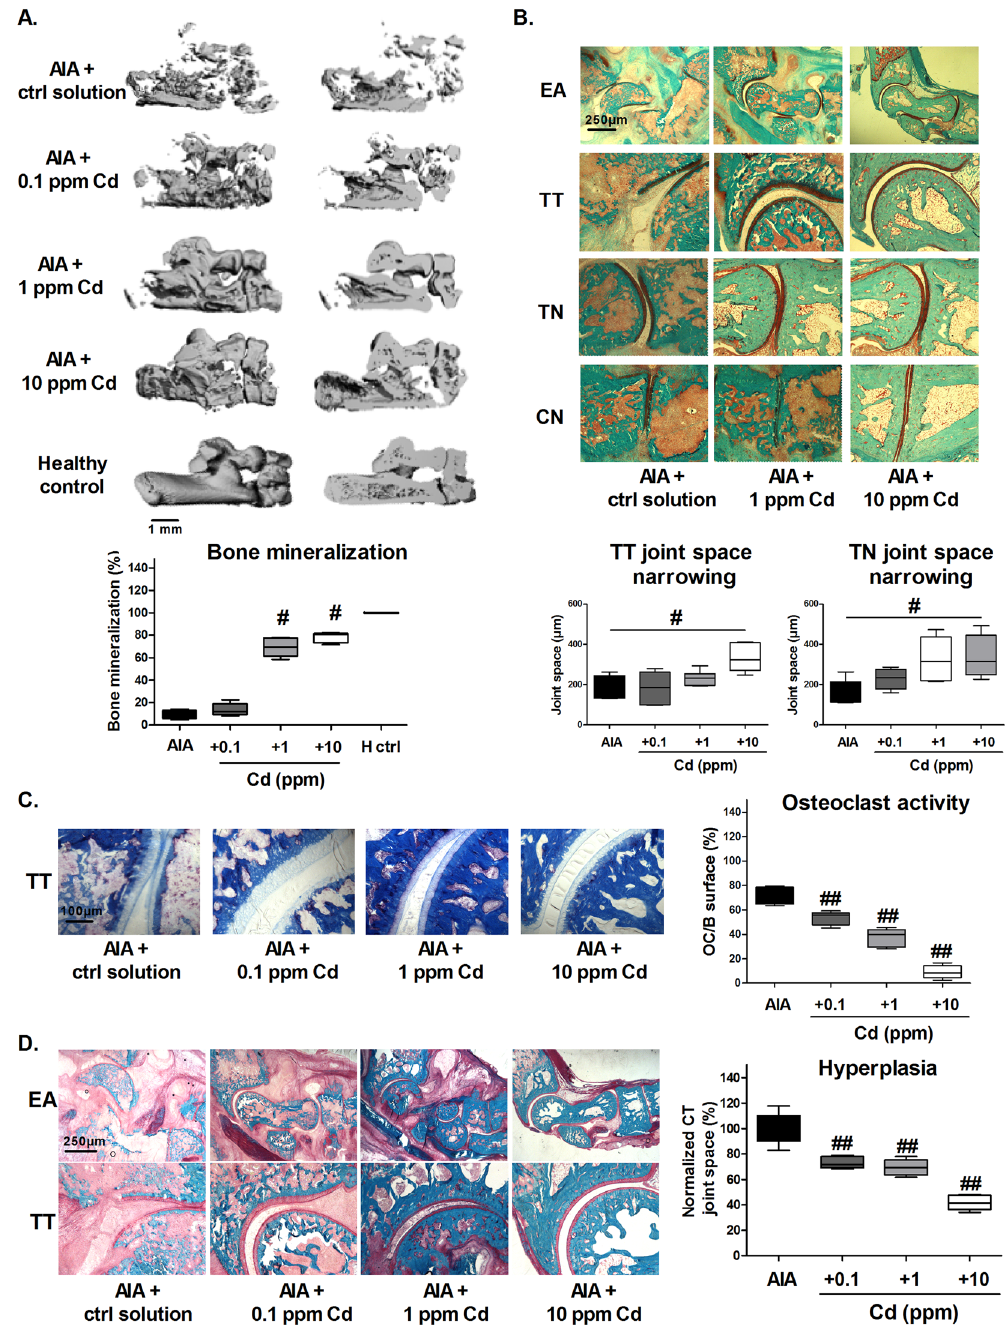
Figure 4. Cd intra-articular injection reduces inflammation-induced bone loss and cartilage destruction in AIA rats. ( A ) 3D-images reconstructed after micro-computed tomography analysis of hind ankle bones and quantification of bone mineralization of navicular bone ( B ). Safarin-O Cartilage staining and joint space narrowing quantification between talus and tibial or talus and navicular bones. Mineralized tissue in green, cartilage in red-orange. ( C ) TRAP staining in the TT space and quantification of osteoclast activity ( D ). Representative modified trichromatic Goldner staining on ankle sections: blue/green/turquoise: mineralized tissue; red periosteal layer and non-mineralized bone matrix; yellow/orange: bone marrow and other soft tissues; quantification of hyperplasia as calcaneo tibial joint space. EA: entire ankle; TT: talo-tibial; TN: talo- navicular; CN: cuneo-navicular. Data are the mean of two independent measures on 6 animals per group, excepting the AIA plus Cd-1 ppm group, counting 5 animals. Data are represented as mean ± SEM; # p < 0.05, ## p <